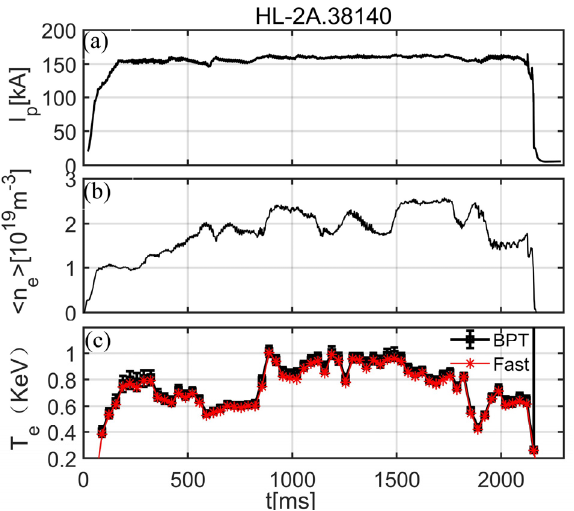
Figure 7. ( a , b ) Time trace of the plasma current and midplane line average electron density by Far Infrared Ray interference system (FIR). ( c ) Time evolution of the core plasma temperature obtained by two fitting programs. “BPT” is the program based on the Bayesian probability inference method in reference 15, and “Fast” is the code used here for the (cid:1846) (cid:3032) preview.